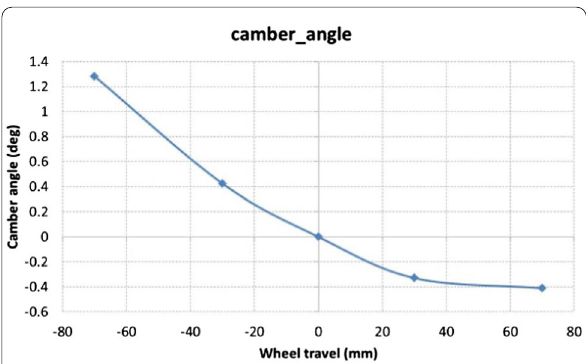
Figure 5 Camber angle change with wheel travel